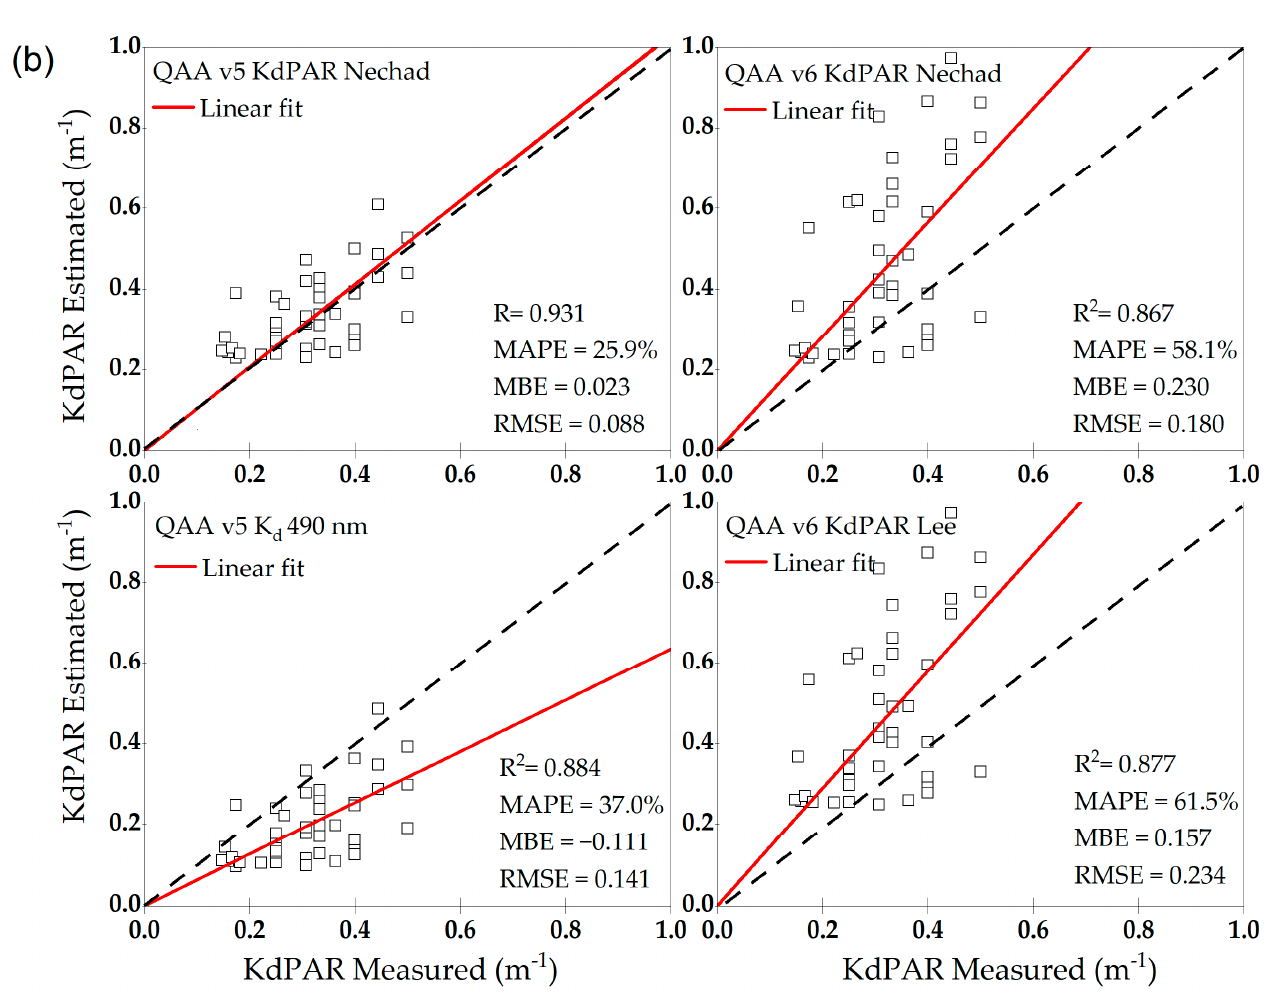
Figure 3. Estimated and measured KdPAR using different algorithms during ( a ) summer ( n = 55) and ( b ) spring ( n = 43), n represents the sample size. The dashed black line is the 1:1 line. Red lines indicate the fitting using the least-squares regression method.